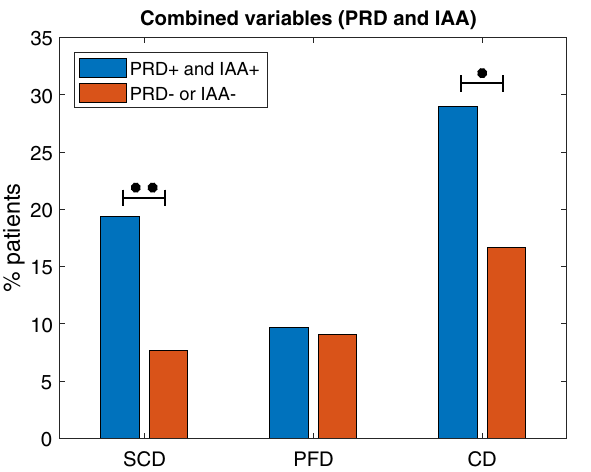
Figure 4. Percentages of SCD, PFD and CD victims in the PRD + and IAA + group and the rest of patients. ∗ p < 0.05 , ∗∗ p < 0.01 .